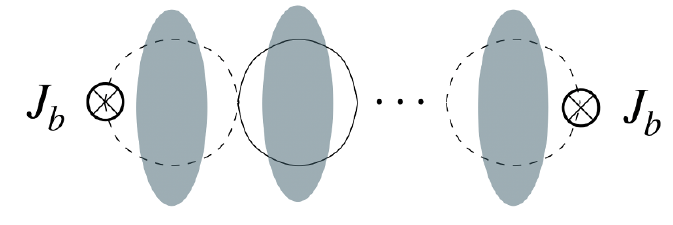
Figure 1 . Some contributions to the large N two-point functions of J b and J f . Dashed lines indicate the scalar (cid:30) , solid the fermion , wavy lines the gauge (cid:12)eld, crosses insertions of J b and J f .